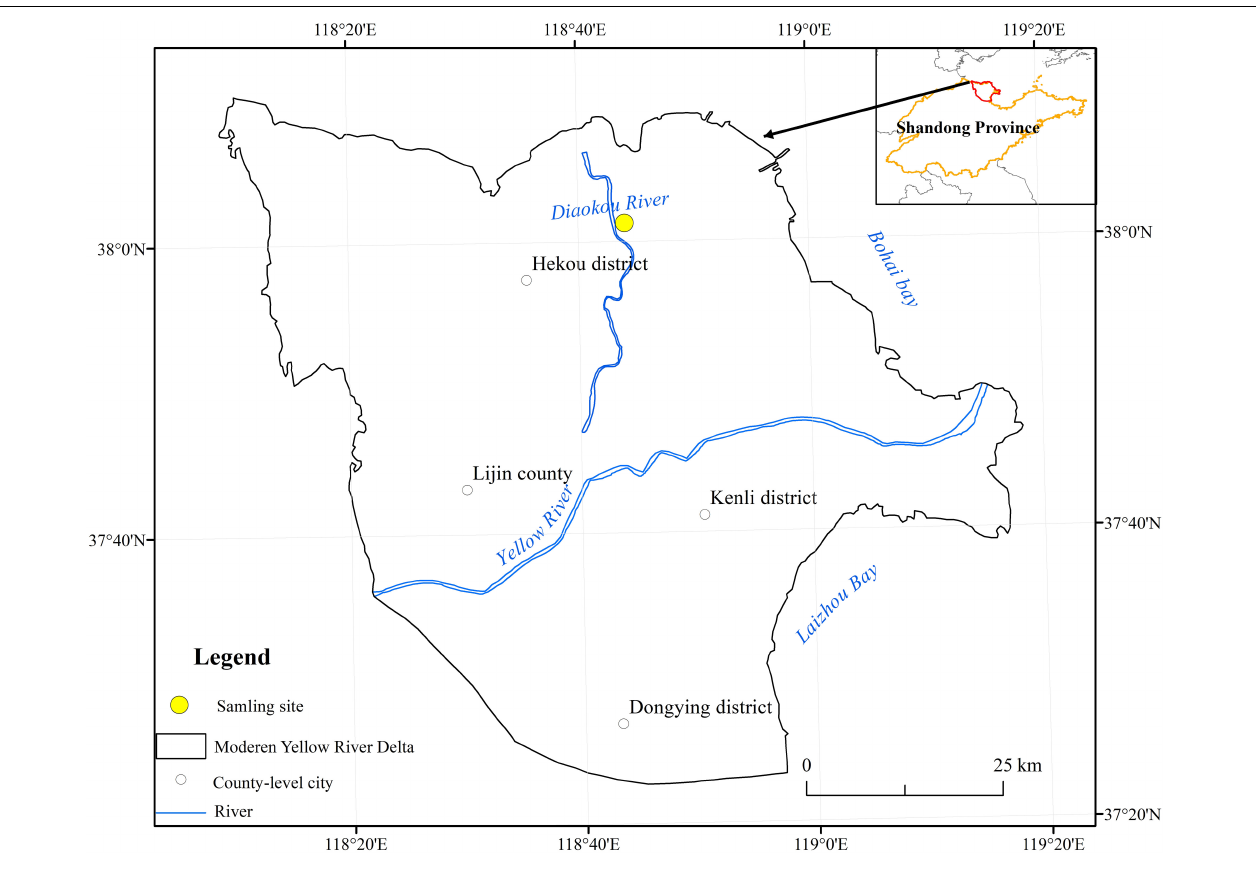
FIGURE 1 | Schematic diagram of sampling